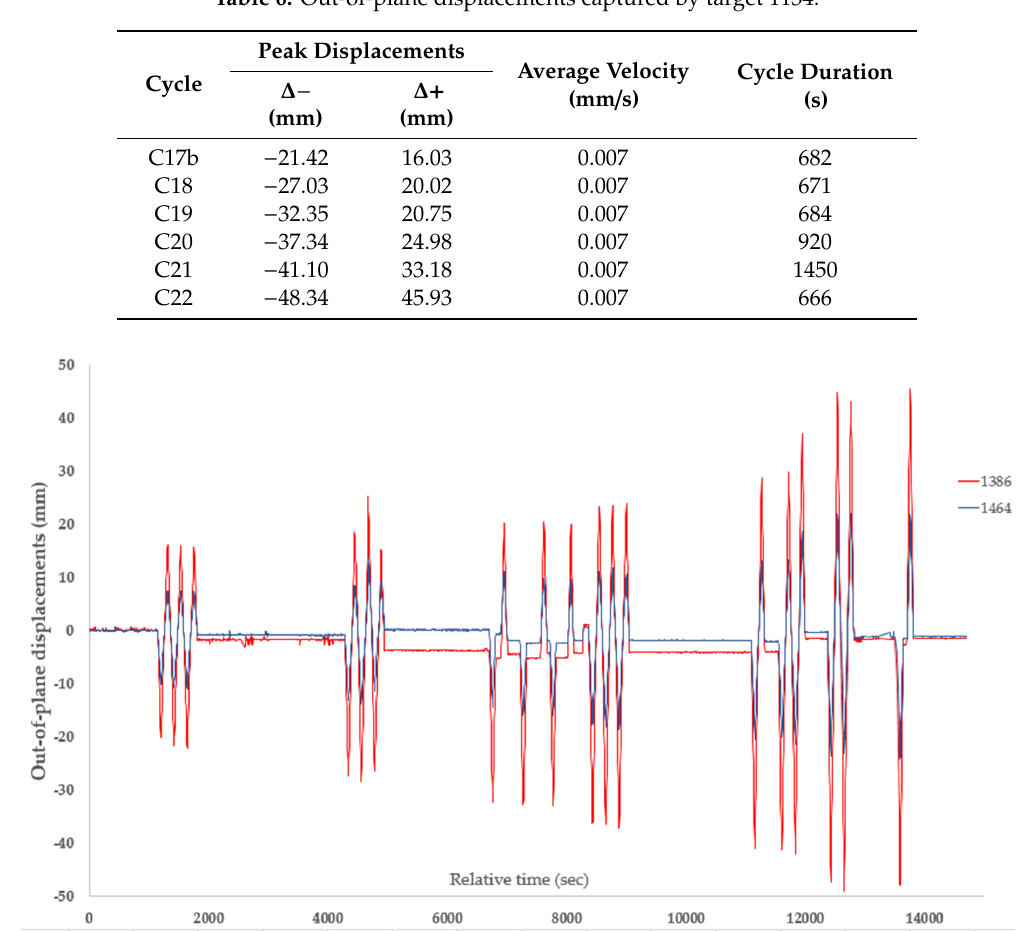
Table 6. Out-of-plane displacements captured by target 1134.